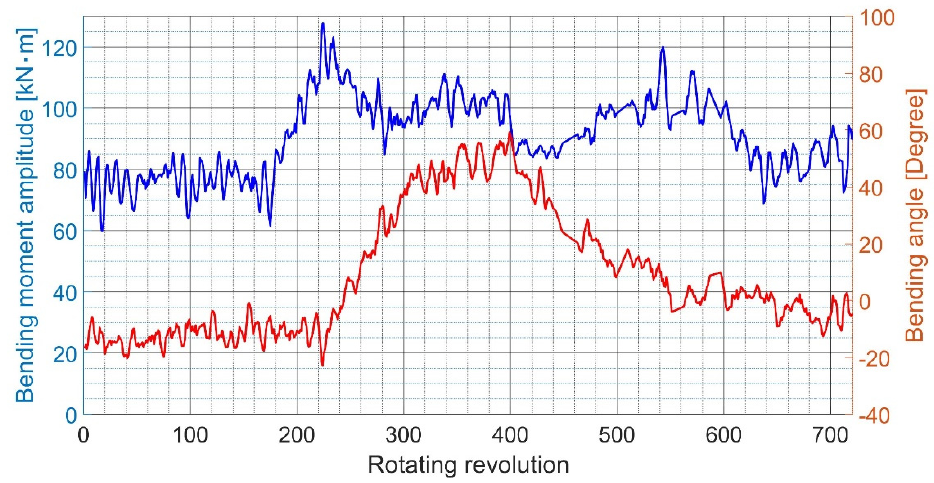
Figure 12. Bending moment in the horizontal direction during the port turn under the fully laden condition.